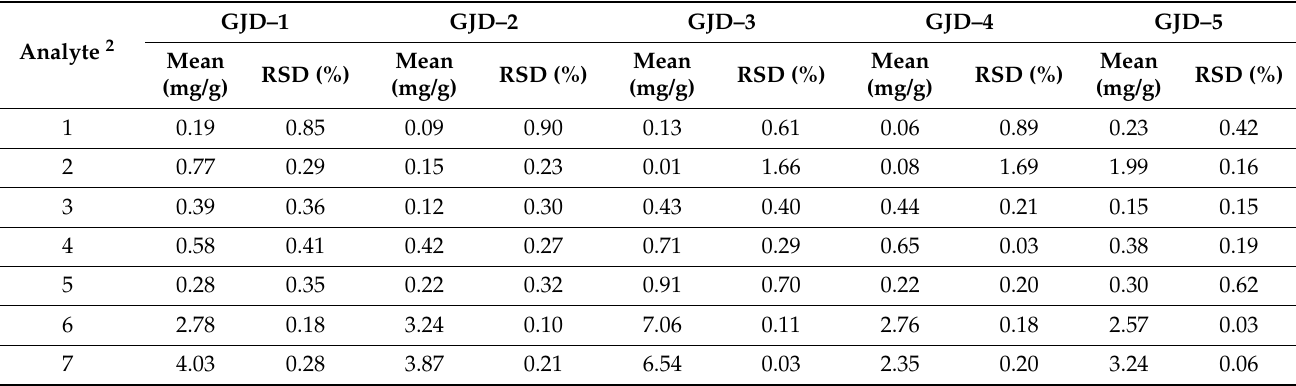
Table 5. Amounts (mg/g) of the seven target components in commercial products, determined using the developed HPLC method 1